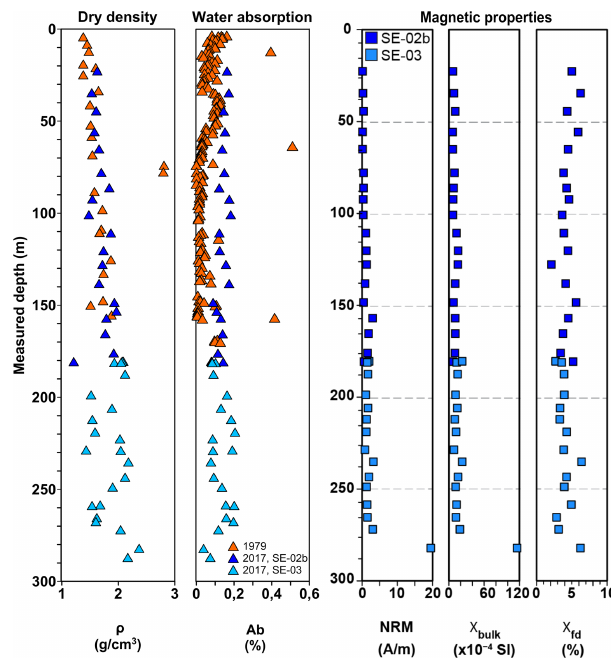
Figure 3. Material and magnetic measurements of Surtsey drill core samples. Dry density and water absorption (ASTM C97/C97M-18), 1979 SE-01 (Jakobsson and Moore, 1982; Oddsson, 1982), and 2017 samples and reference samples, SE-02b and SE-03 (Table S1). Magnetic properties, natural remanent magnetization (NRM), bulk magnetic susceptibility ( χ bulk , recorded as χ LF ), and frequency- dependent magnetic susceptibility ( χ fd ) of 2017 reference samples, SE-02b and SE-03 (Table